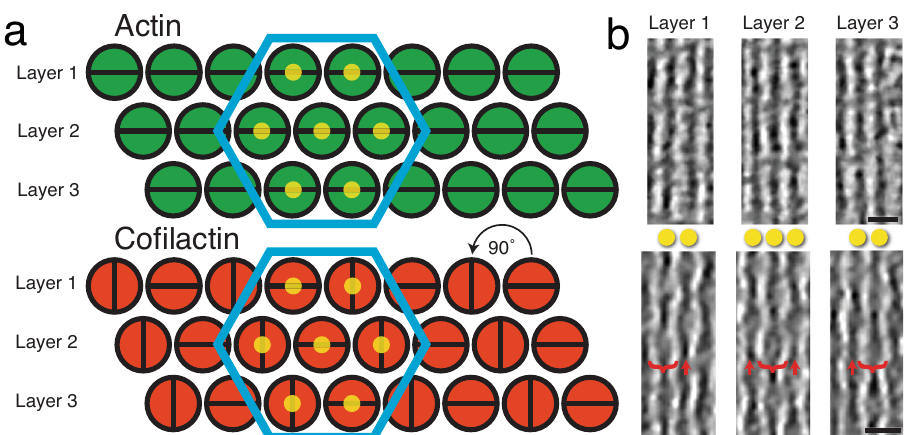
Fig. 3 Higher-order structure of fi lopodial bundle types. a Schematic model of the higher-order structure of actin (fascin-linked) and co fi lactin bundles in growth cone fi lopodia (as they appear looking down the long axis of the bundle). Filaments in both bundle types are organized in layers and hexagonally packed (blue hexagons). Filaments in the actin bundle are all twisting in phase with one another, but in the co fi lactin bundle fi laments are rotated 90° with respect to their neighbors in the same layer. This creates columns of fi laments that are oriented similarly to one another. The yellow dots on fi laments in the hexagon correspond to fi laments in b . b 17 nm-thick slices through tomograms of a fi lopodial tip (top) and a co fi lactin bundle (bottom). In the co fi lactin bundle, brackets show the wide portion of the helical twist while red arrows show the thin portion. The yellow dots correspond to the dots in a . For instance, the bracketed fi lament in layer two is directly between the two fi laments in layers 1 and 3, only on a different Z -plane. Scale bars in b are 20 nm.